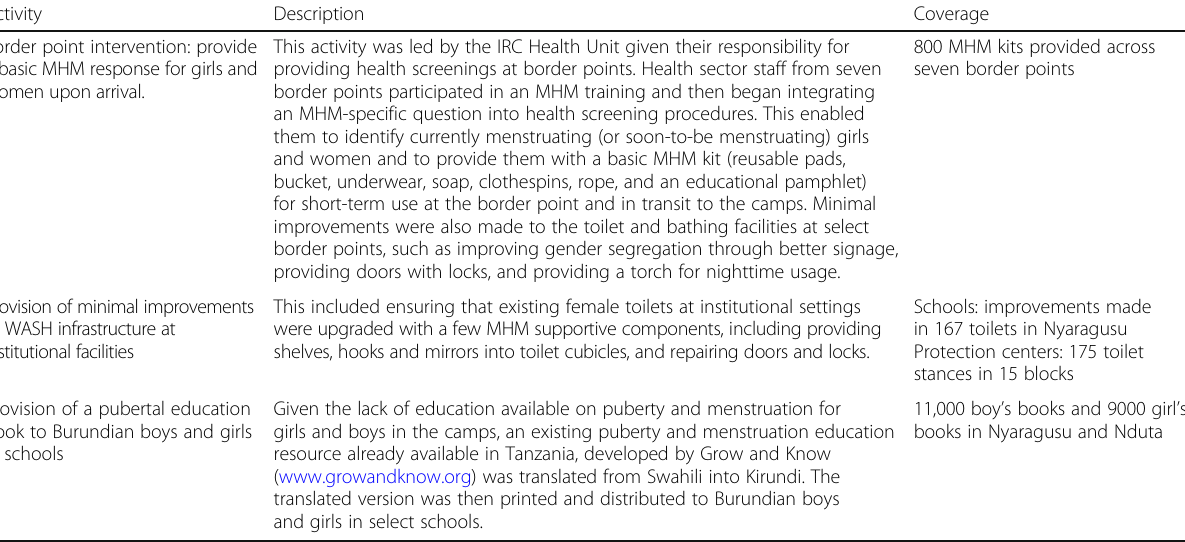
Table 3 Overview of small-scale MHM projects introduced by the pilot team Activity Description Coverage Border point intervention: provide a basic MHM response for girls and women upon